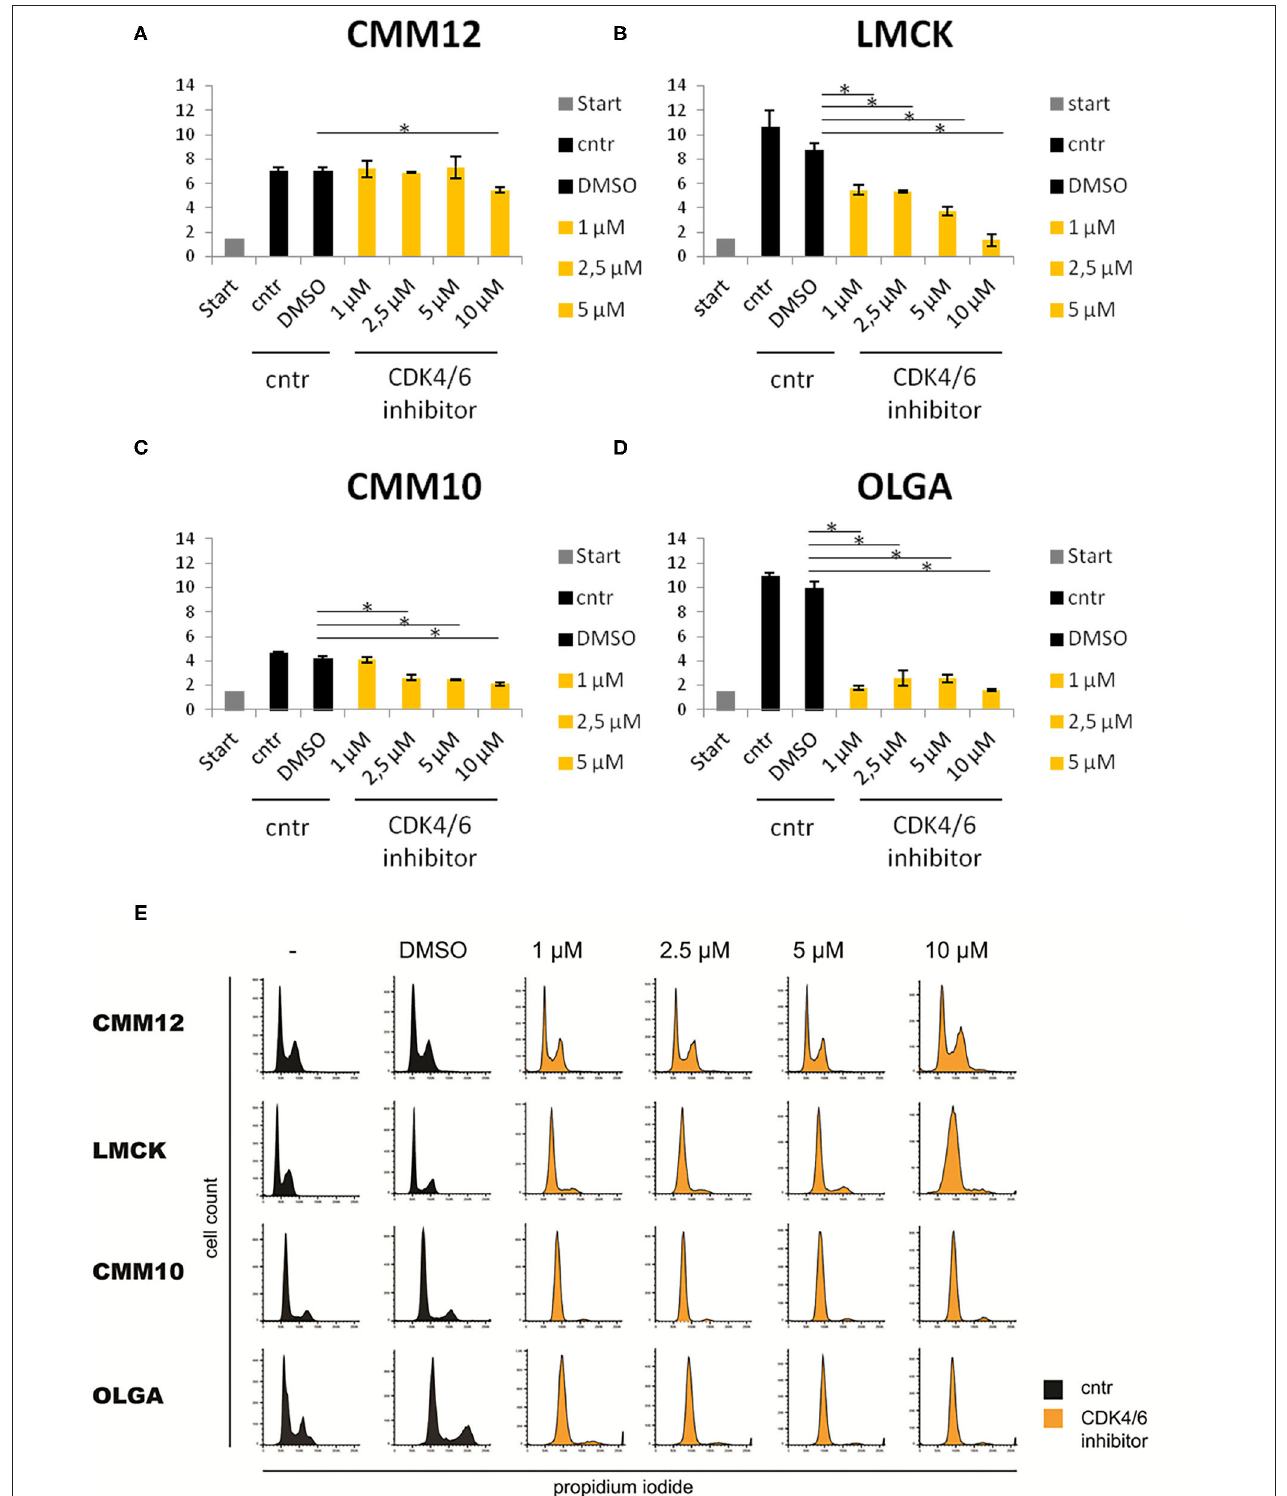
FIGURE 5 | Three of the four tested melanoma cell lines were sensitive to CDK4/6 inhibitor (Palbociclib). Sensitivity of CMM12, CMM10, LMCK, and OLGA melanoma cell lines toward CDK4/6 inhibitor palbociclib. (A–D) Cell numbers of melanoma cells treated with different doses of palbociclib for 48h. Gray bars represent the